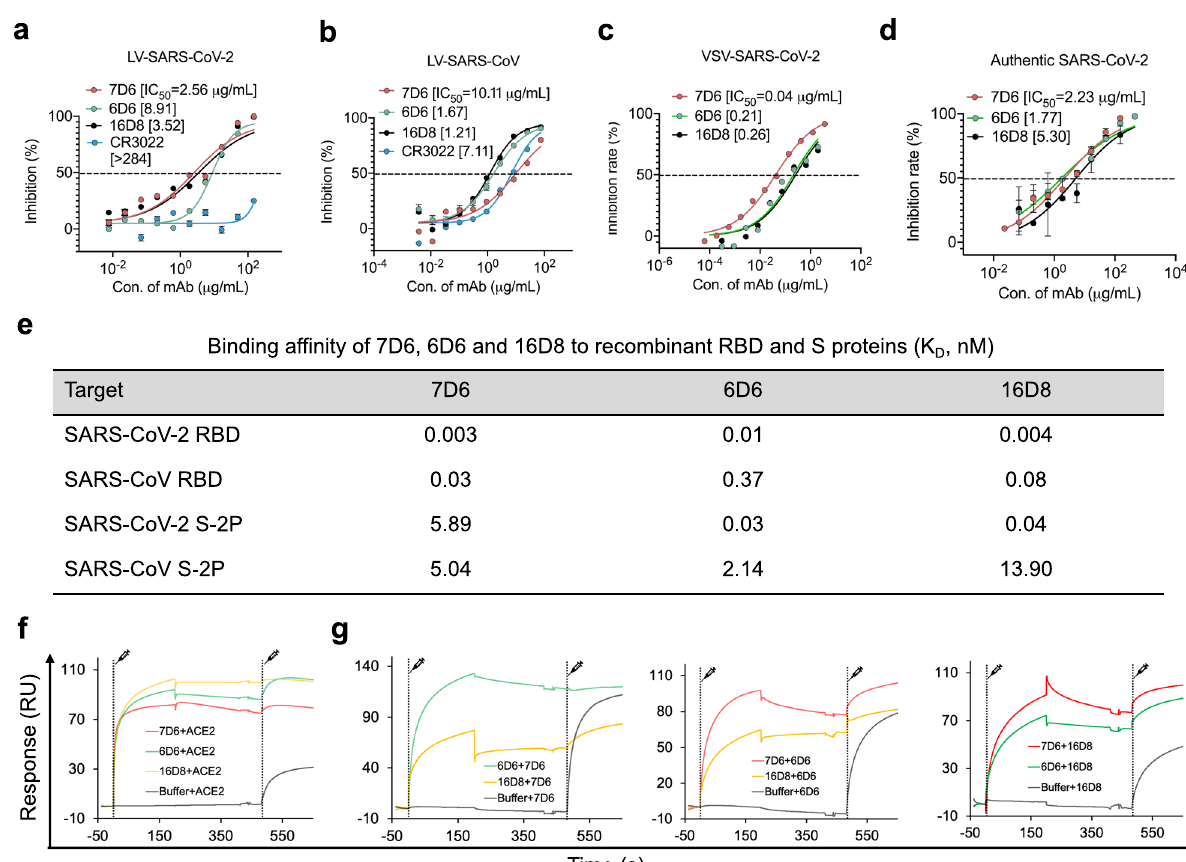
Fig. 2 Comprehensive characterization of representative neutralizing mAbs 7D6, 6D6, and 16D8. a – c Neutralization of three mAbs by LV-SARS-CoV-2 ( a ), LV-SARS-CoV ( b ), and VSV-SARS-CoV-2 ( c ). d Neutralization activities of three mAbs to authentic SARS-CoV-2. e SPR kinetics and the af fi nities of three antibodies to S-2P and RBD proteins of both SARS-CoV-2 and SARS-CoV. f SPR-based blocking assays of the three mAbs perturbing the engagement of ACE2 to RBD. g Inter-blocking potentials of the three mAbs. Data in a , b , d are presented as mean values± SEM. Source data are provided as a Source Data fi